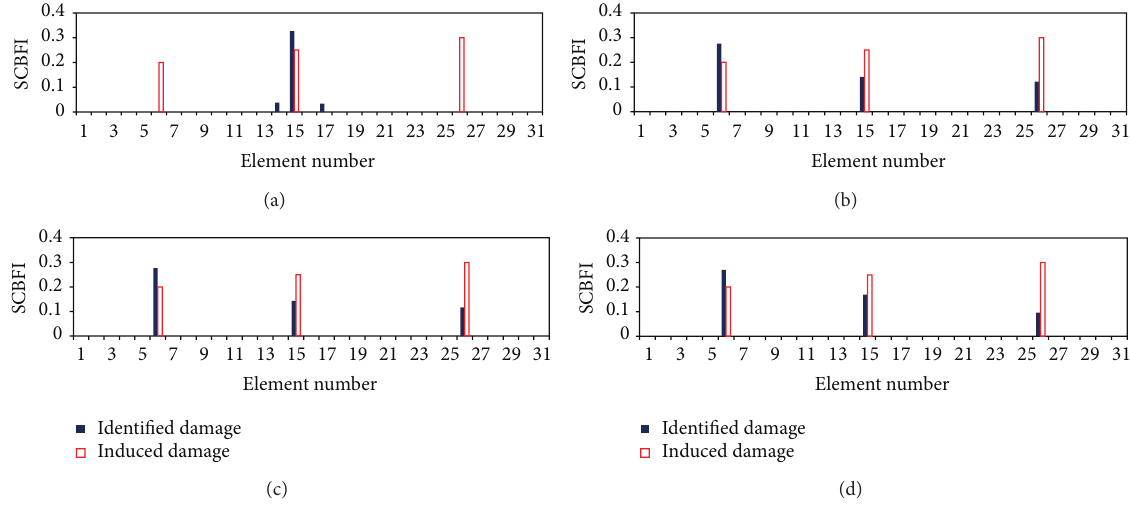
Figure 7: Damage identification for 31-bar truss for case 5 considering (a) 1 mode, (b) 2 modes, (c) 3 modes, and (d) 4 modes.